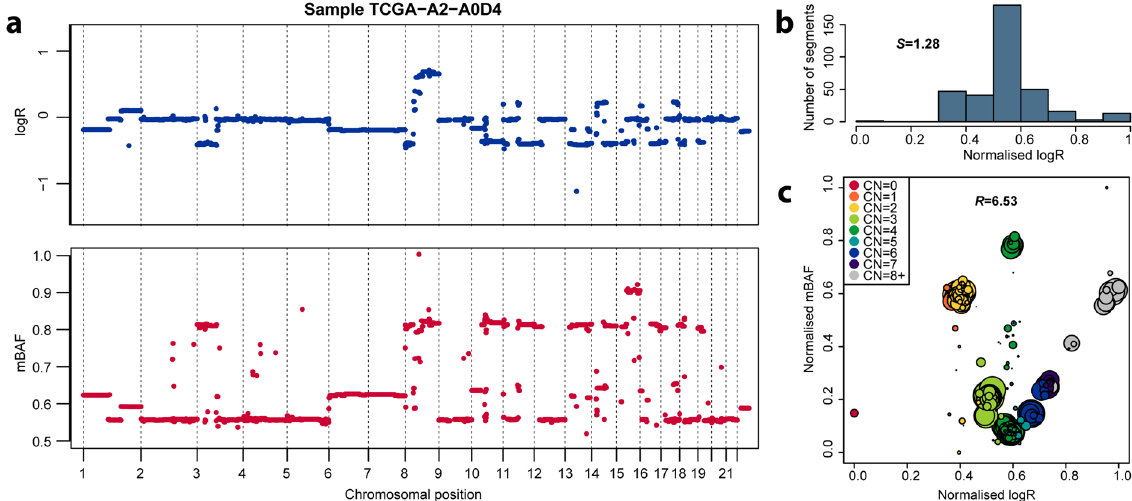
Figure 1. Single-sample SNP array diversity measures. TCGA breast cancer sample TCGA-A2-A0D44 was used as an example, only segments with length > 100 probes are analysed. Normalisation was performed so that both logR and mBAF values would range from 0 to 1. ( a ) Segmented logR and mirrored B allele frequency (mBAF) data. ( b ) 10-bin histogram of normalised logR values. ( c ) 2D plot of all segments. Circle are centred on the logR and mBAF values of each segment, their sizes are proportional to segment length. Colours indicate the total copy number of each segment, as reported by